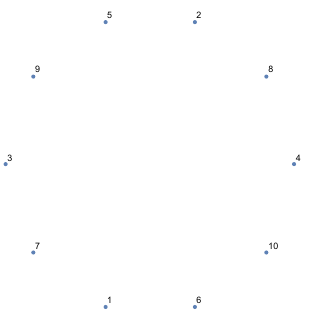
Figure 14 . The I 1 locus of the deformed type II (cid:3) model. The numbers labeling the points are the ordinals of the roots in eq.